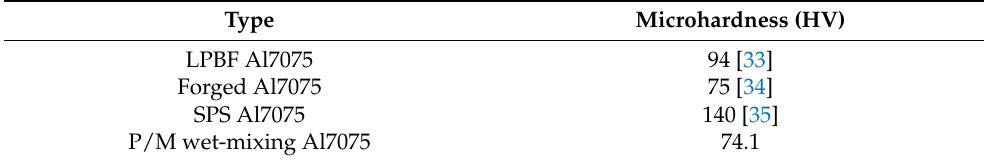
Table 5. Microhardness of Al7075 with different manufacturing technologies.